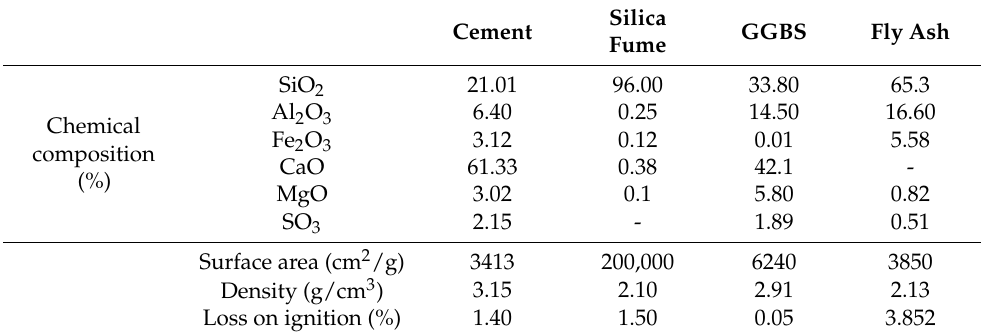
Table 2. Chemical composition and physical properties of supplementary cementitious